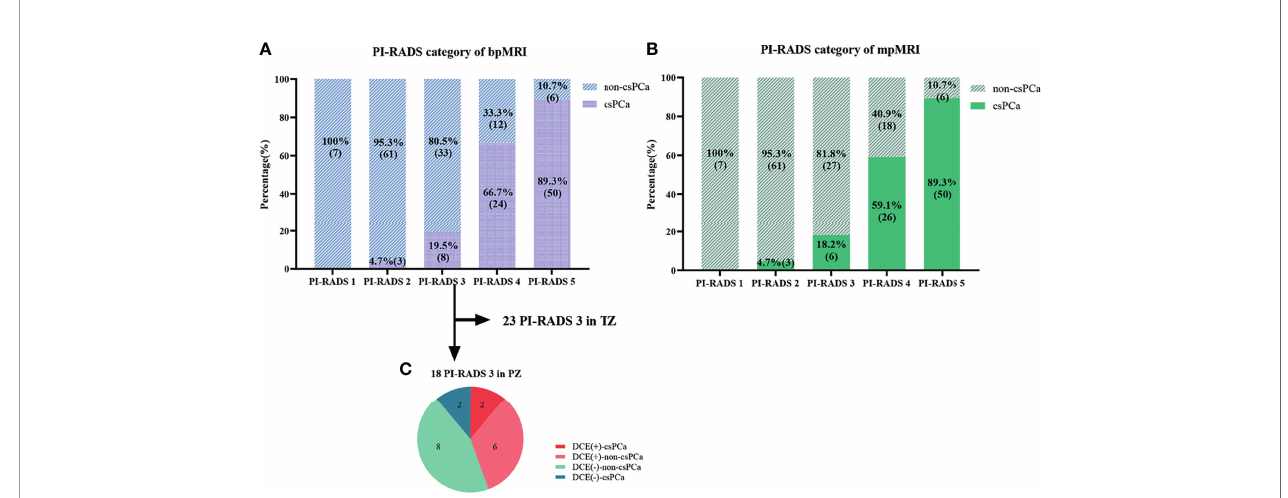
FIGURE 3 | Comparison of the PI-RADS categories and pathological results. (A, B) Graphs show changes in the PI-RADS v2.1 category with bpMRI and mpMRI, as well as the relationship between the PI-RADS categories and pathological results. (C) Graph shows results of DCE and the histopathologic fi ndings of the 18 patients with PI-RADS 3 lesions in the peripheral zone (PZ).